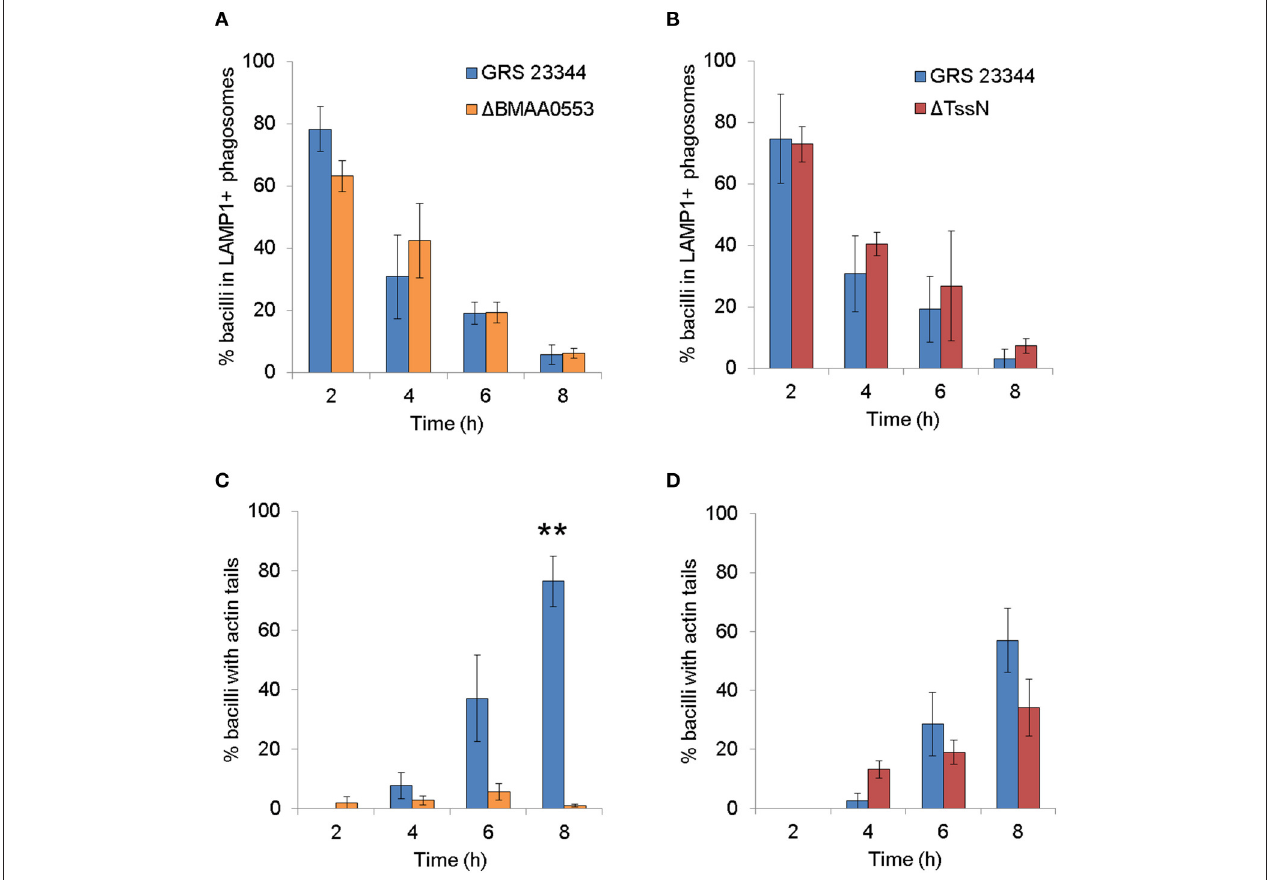
FIGURE 2 | Confocal analysis of the interaction of Burkholderia mallei ( Bm ) with RAW 264.7 cells. Macrophage-like cells were incubated with GRS 23344 ( blue ), 1 BMAA0553 ( orange ), or 1 TssN ( red ), stained and then visualized by confocal microscopy. The colocalization of the respective Bm strains with LAMP-1 (A,B) or actin tails (C,D) was quantified at the times indicated postinfection. The graphs are based on three independent experiments. The number of bacilli counted was 686 for (A) , 724 for (B) , 673 for (C) , and 818 for (D) . The columns represent the mean, and bars represent the standard errors. An “**” indicates a significant difference at p < 0.001